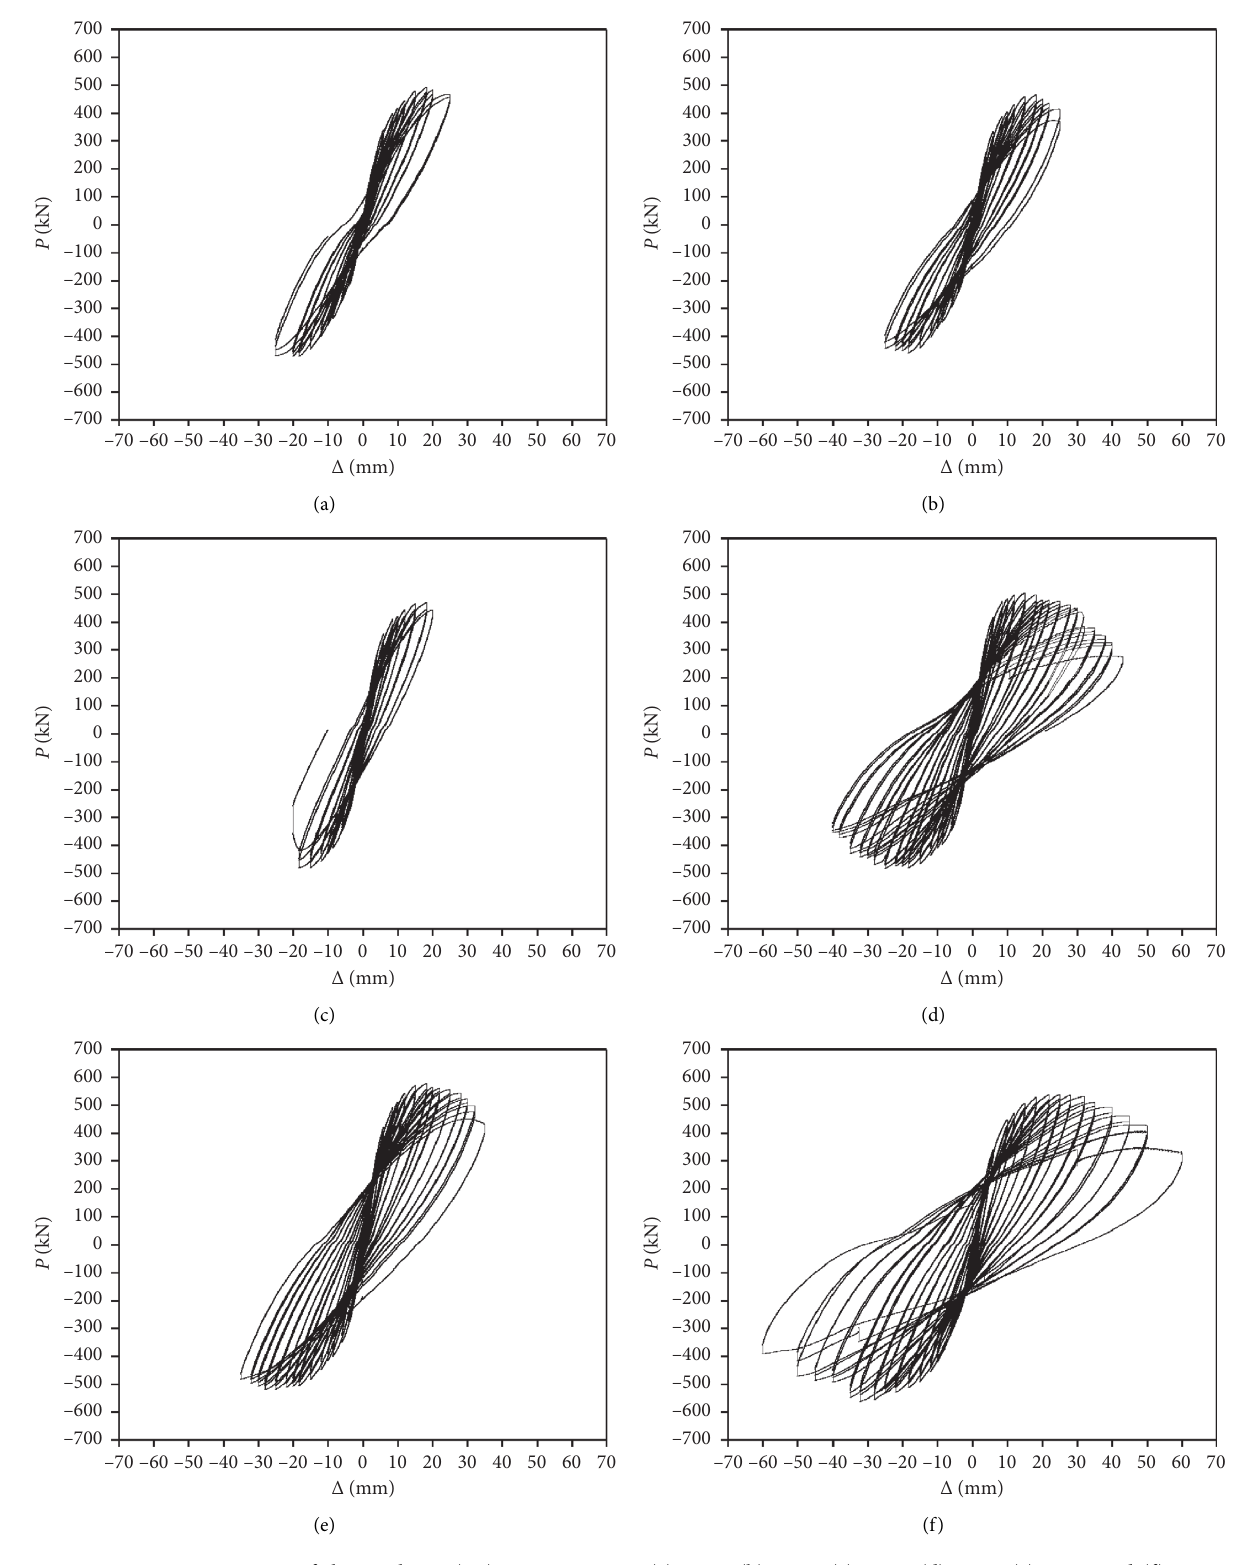
Figure 7: Hysteretic curves of short column (SC) specimens 1–6. (a) SC-1, (b) SC-2, (c) SC-3, (d) SC-4, (e) SC-5, and (f) stress and deformation during the loading of the specimen.